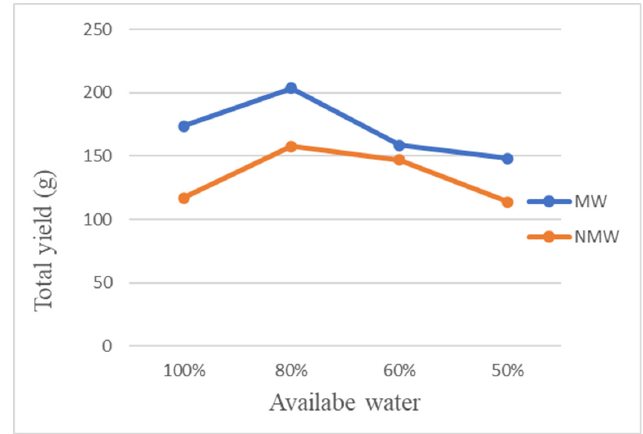
Figure 6. Figure 6.Figure 6. Figure 6. Yield of the popcorn at different levels of available water applied MW = Magnetized Water (Magnetic treatment of irrigation water); NMW = Non-Magnetized